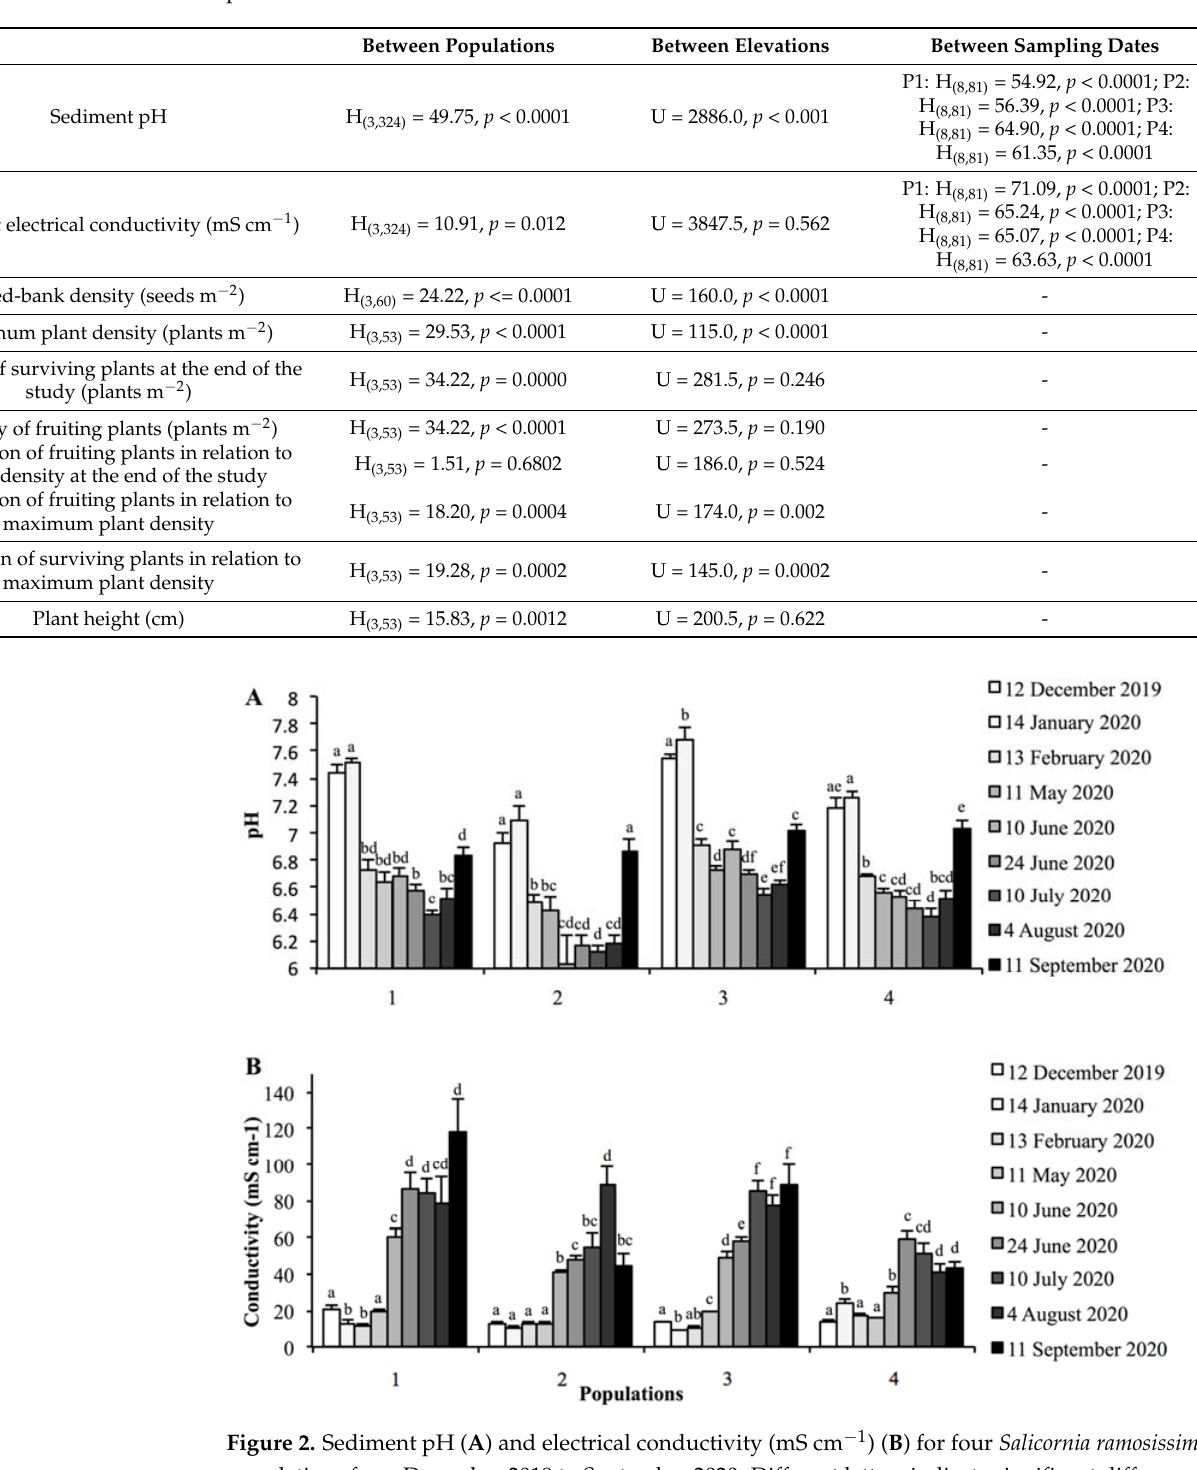
Table 2. Kruskal–Wallis test and Mann–Whitney U-test comparing between four populations of Salicornia ramosissima , two salt-pan elevations and nine sampling points for sedimentary and plant variables.